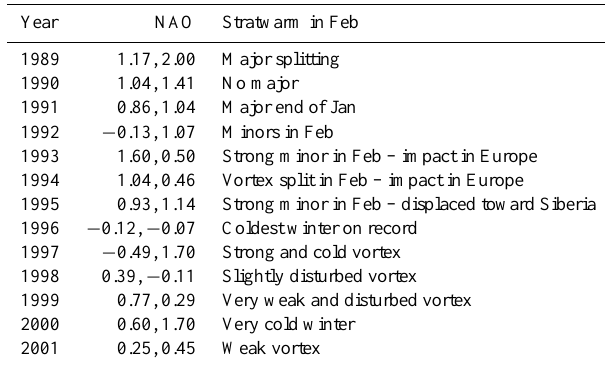
Table 4. NAO index for January and February, respectively and in- formation about stratospheric warming and/or state of polar vortex in February,